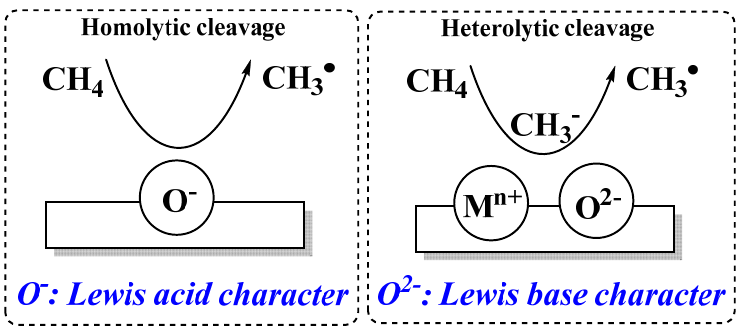
Figure 28. Simplified illustration of CH 4 activation via homolytic and heterolytic routes involving different active sites on a metal oxide catalyst surface.